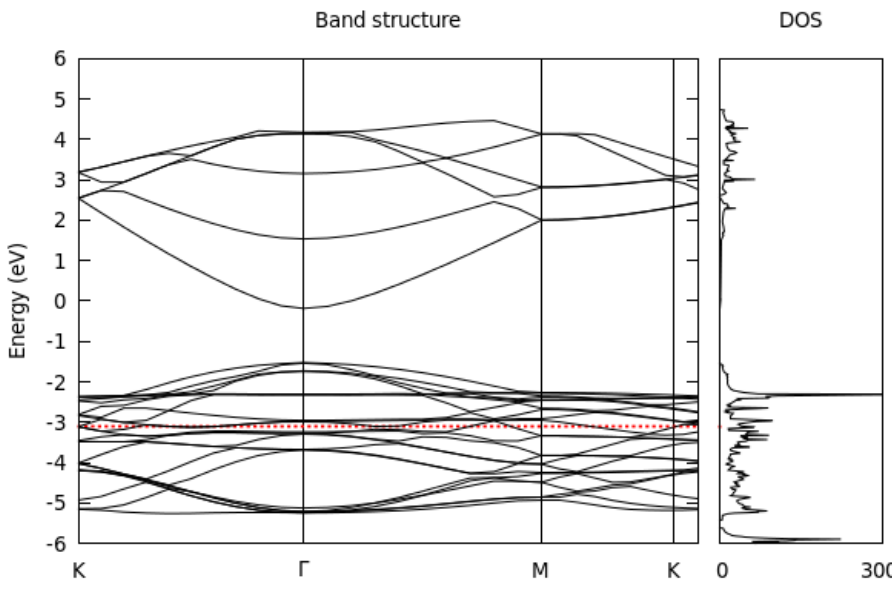
Figure 3: Band structure and DOS of ZnO in the doublelayer graphene-like structure. The red dashed line is the Fermi level found for